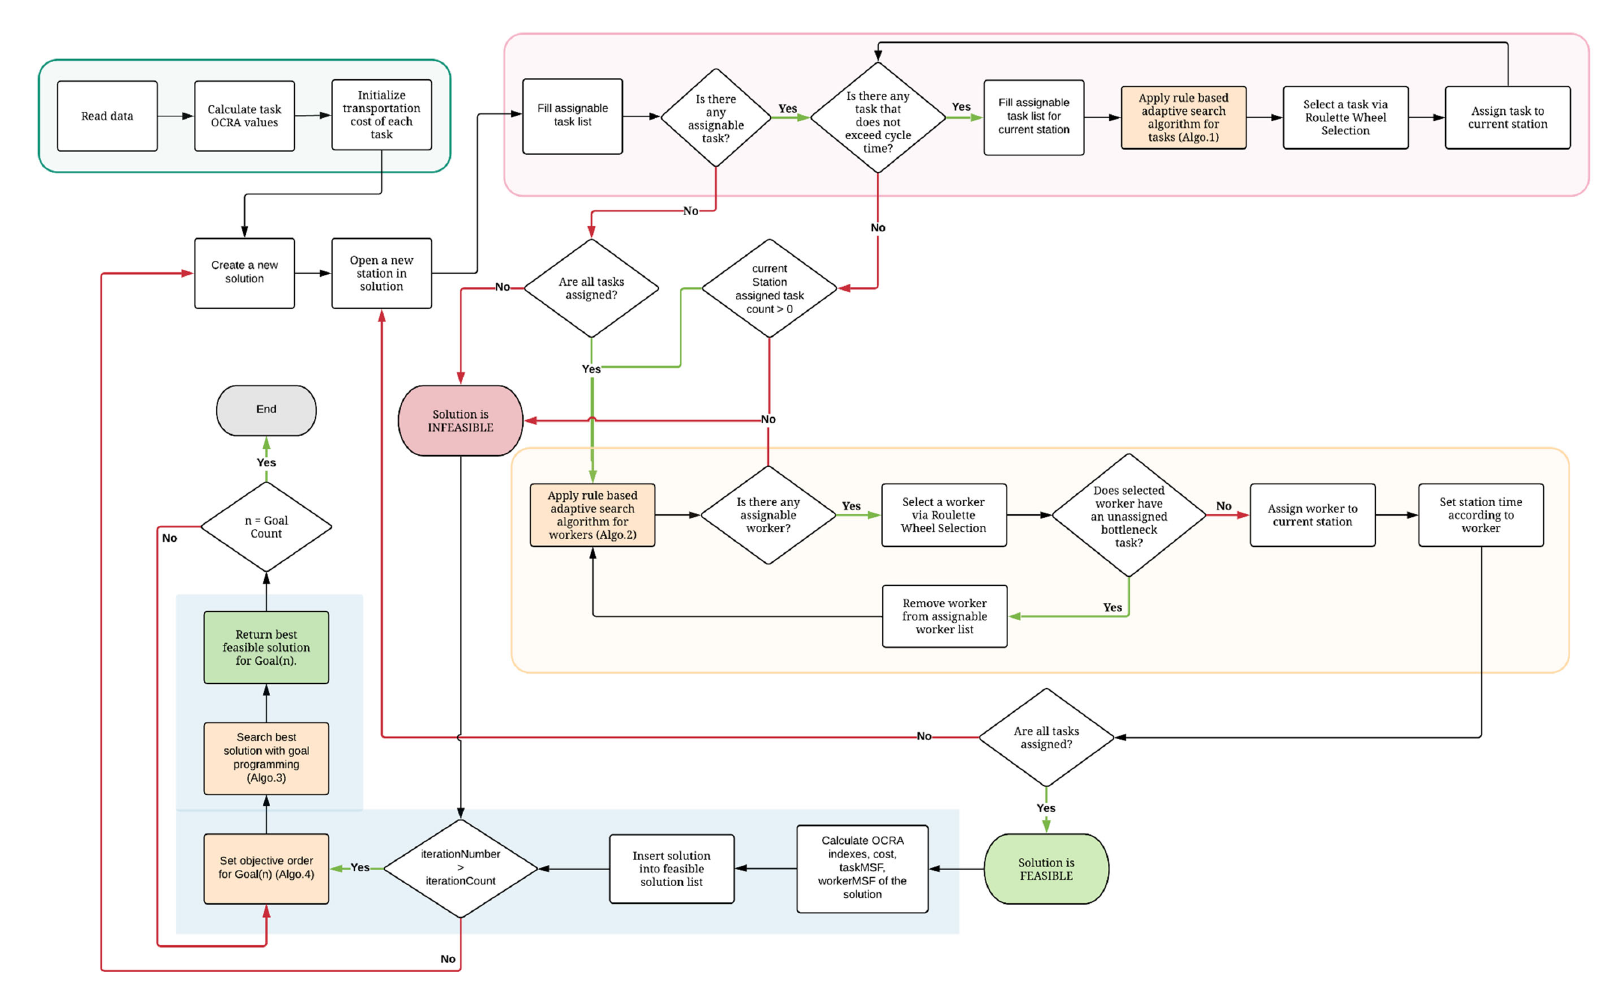
Fig.1 Flowchart of the proposed heuristic solution